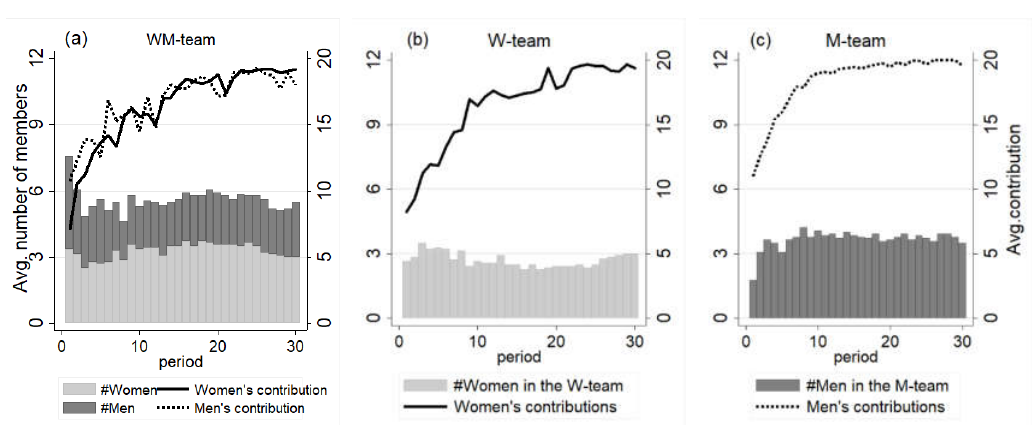
Figure 2. Average numbers (bars) and average contributions (lines) of women and men in each period. Bars in panel ( a ) provide the average number of women (grey bars) and men (black bars) in the WM-team over periods. The grey bars in panel ( b ) show the corresponding average number of women in the W-team and the black bars in panel ( c ) show the corresponding average number of men in the